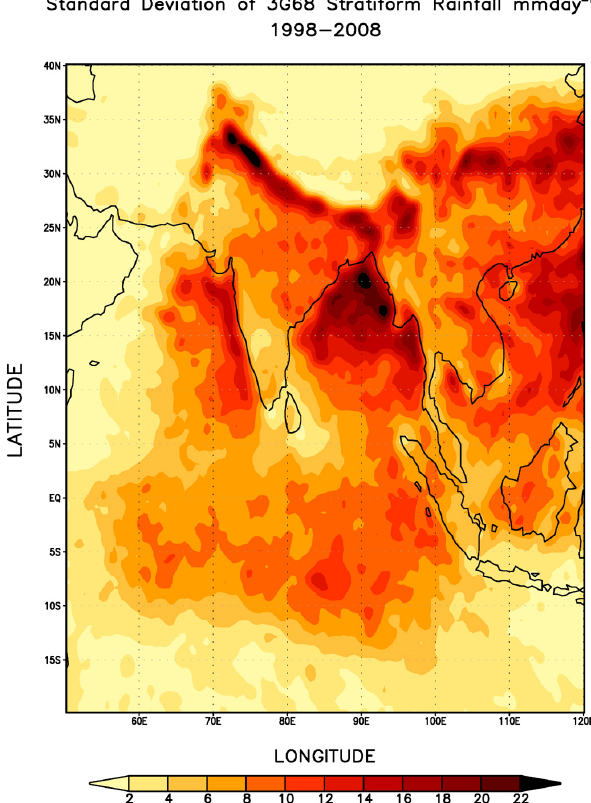
Fig. 12. Standard deviation of JJAS stratiform rainfall (mmday − 1 ) based on 3G68 data from